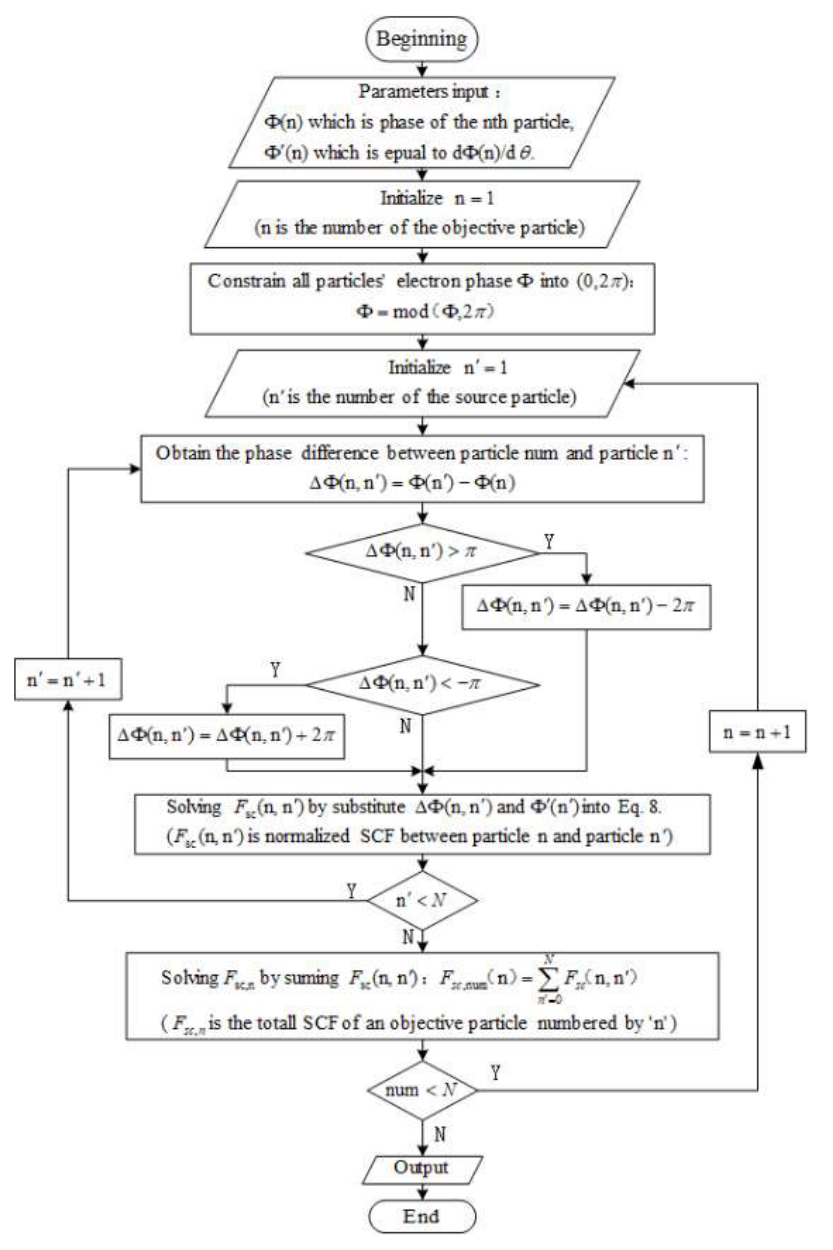
Figure 5. The schematic diagram of the traditional algorithm.